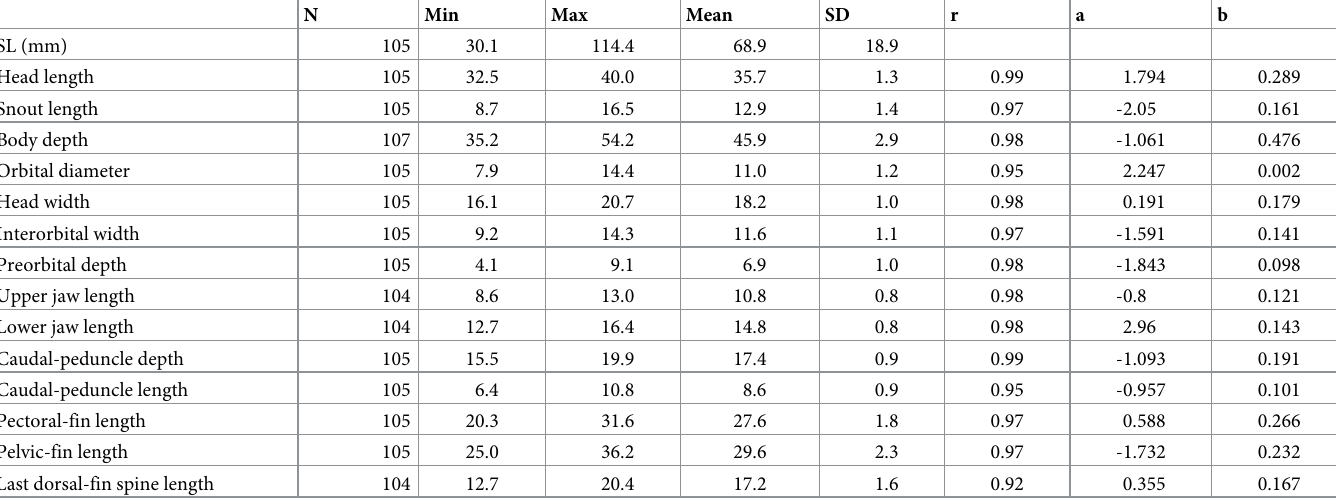
Table 12. Australoheros acaroides . Size (SL), proportional measurements (per cent of SL), and linear regression parameters. N Min